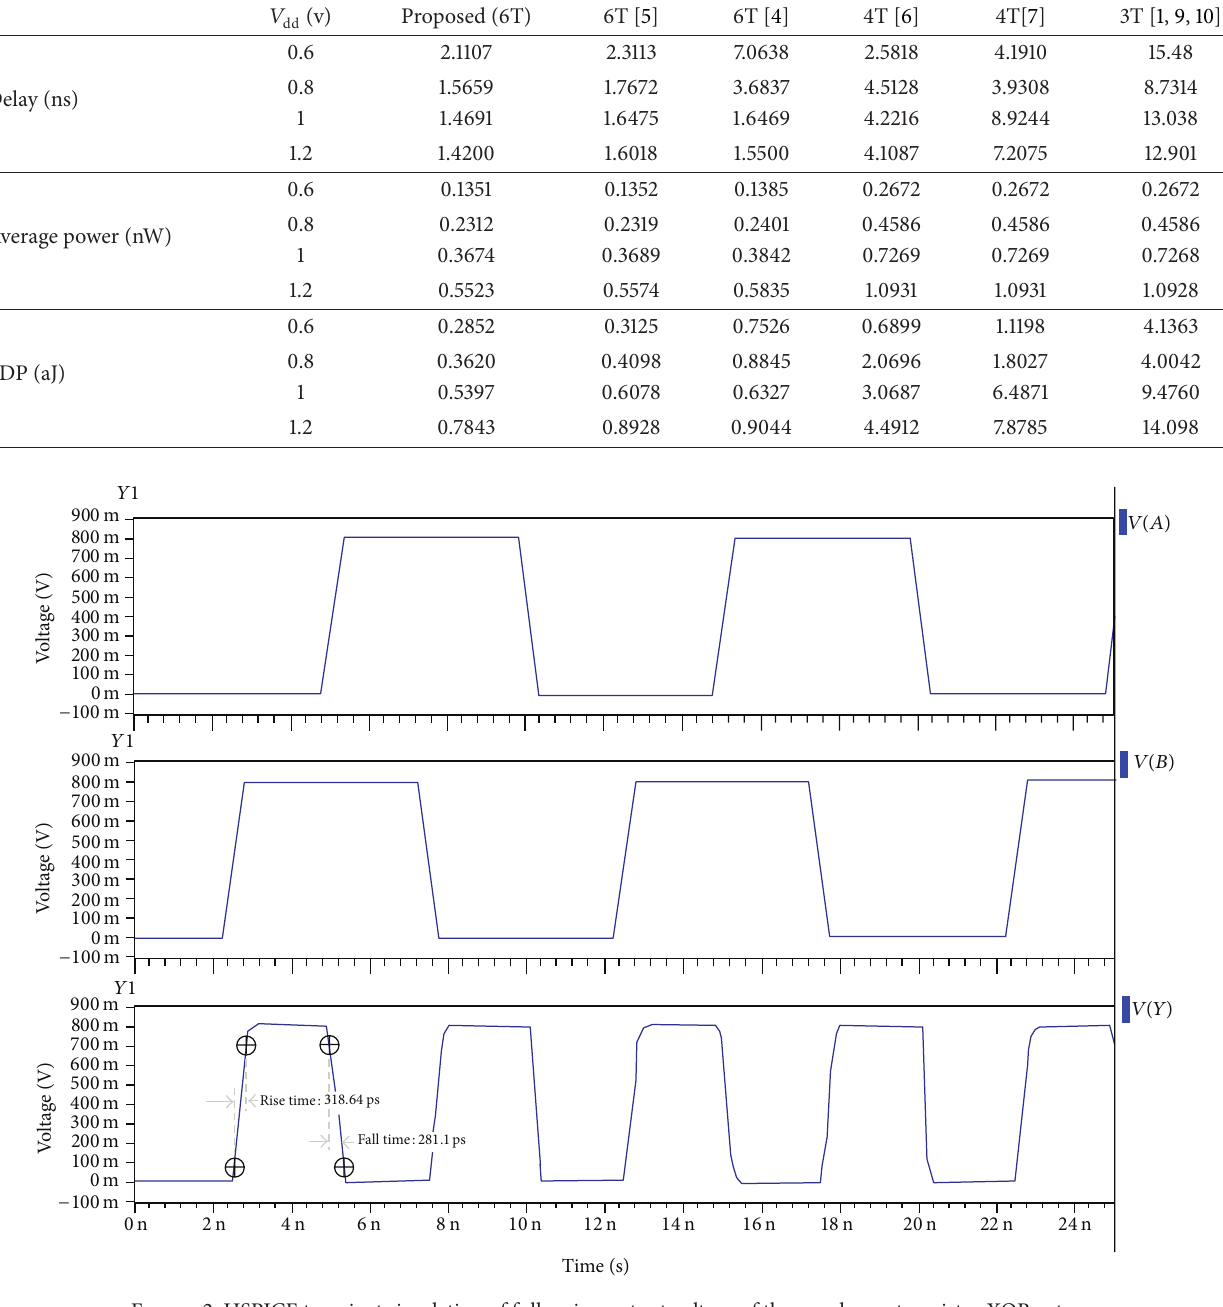
Figure 2: HSPICE transient simulation of full-swing output voltage of the novel pass-transistor XOR